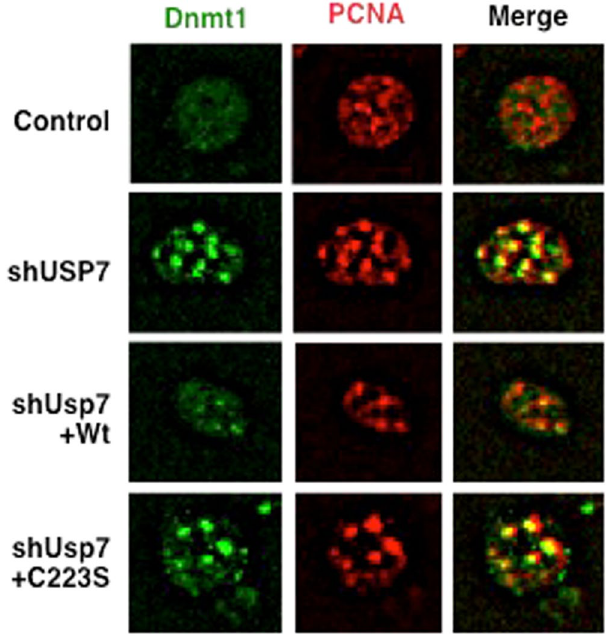
Figure 5. Usp7 is involved in recruitment of Dnmt1 to DNA replication sites in mammals. HeLa cells expressing shRNA-resistant wild-type Usp7(Wt) or its mutant (C223S) were infected with lentiviruses expressing tet-on shRNAs targeting Luciferase (Control) or Usp7 and treated with doxycycline (1 μ g/ml) for 72 hrs. The resultant cells were subjected to immunostaining using anti-Dnmt1 (green) and anti-PCNA (red)